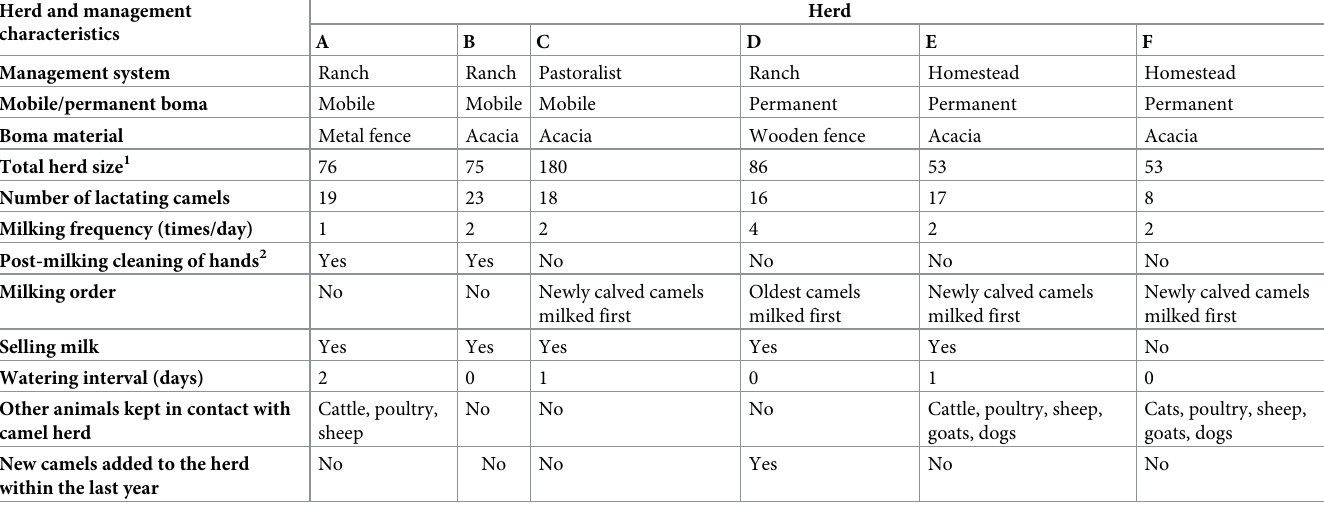
Table 1. Herd demographics and management characteristics of six dairy camel herds from a study into carriage and shedding of group B Streptococcus conducted in November 2019 in Laikipia County, Kenya. Herd and management